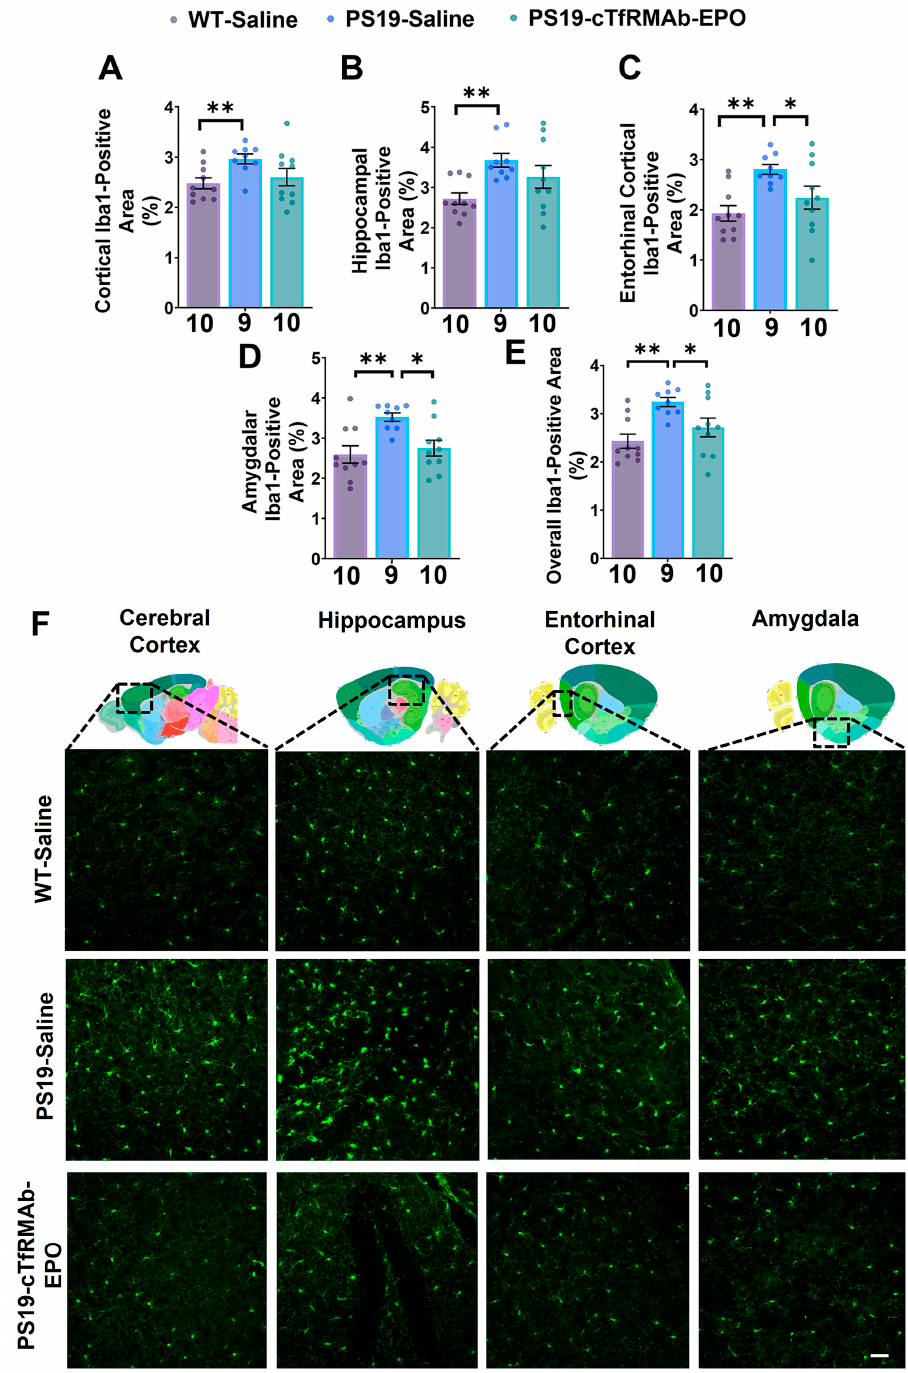
Figure 3. Effect of cTfRMAb-EPO on microgliosis in the PS19 mice with Iba1 immunostaining. ( A – F ) The Iba1-positive area in different brain regions. The Iba1-positive area was significantly lower in the cTfRMAb-EPO-treated PS19 mice compared to the saline-treated PS19 mice in the entorhinal ( C ) cortex and ( D ) amygdala. ( E ) The overall Iba1-positive area, which is the average of all the brain regions, was also significantly reduced with cTfRMAb-EPO. ( F ) Representative images of Iba1-positive microglia with thumbnail brain section images adapted from the Allen Institute that show the cerebral cortex, hippocampus, entorhinal cortex, and amygdala. Data are presented as mean ± SEM of n = 9–10 per treatment group (shown below each column). No outliers were detected. One-way ANOVA with Holm–Sidak’s post hoc test was used to compare to the PS19-Saline group. * p < 0.05, ** p < 0.01. Scale bar = 100 µm.